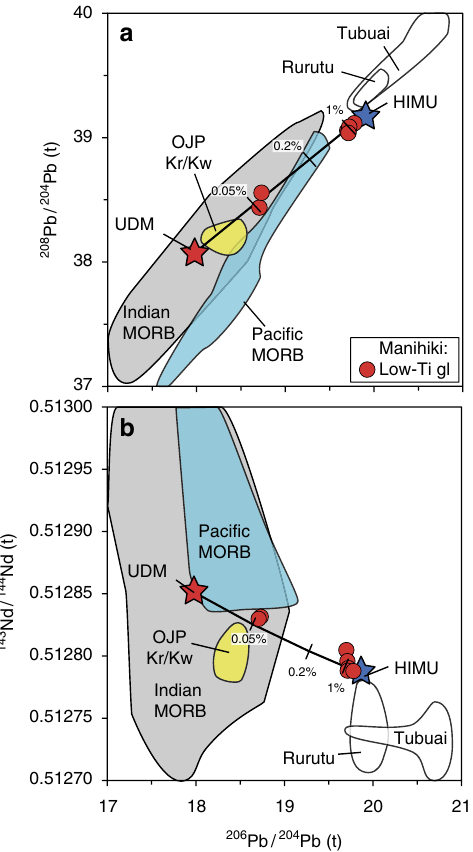
Figure 3 | Radiogenic isotopic composition of low-Ti Manihiki rocks. Initial radiogenic isotope ratio plots (with correction for radiogenic ingrowth to 120Myr ago) of ( a ) 206 Pb/ 204 Pb versus 208 Pb/ 204 Pb and ( b ) 206 Pb/ 204 Pb versus 143 Nd/ 144 Nd for low-Ti glasses. The stars represent the estimated UDM (red) and enriched (blue) end members for the Manihiki low-Ti tholeiites. The enriched melt end member for the Manihiki low-Ti tholeiites has characteristics similar to HIMU-like OIB lavas from Rurutu and Tubuai 69 of the Cook-Austral Chain (see discussion, Supplementary Fig. 2 for calculation of the Manihiki-enriched end member). The black lines show mixing of UDM with variable amounts (indicated at tick marks in wt%) of the enriched OIB-like component represented by a mafic Rurutu lava sample from ref. 34. Note: 143 Nd/ 144 Nd ratio for intermediate sample SO225DR12-2 was not included for end member calculations (see ‘Sample material’ in the ‘Methods’ section). Isotope data for the Kroenke/Kwaimbaita field were taken from refs 10,11. The MORB-field data 70 were projected to 120Myr using the following parent/ daughter ratios from ref. 4: 147 Sm/ 144 Nd ¼ 0.25, 87 Rb/ 86 Sr ¼ 0.005, 238 U/ 204 Pb ¼ 10, 235 U/ 204 Pb ¼ 0.073, 232 Th/ 204 Pb ¼ 40. The Indian MORB 70 field was projected to 120Myr using calculated parent/daughter ratios based on the incompatible element composition of E-DMM from ref. 33. The fields for the Tubuai and young Rurutu lavas were also projected to 120Myr ago and plotted based on compiled literature data and parent/daughter ratios from the calculated OIB source from ref. 36 and references and spinel, which are the only liquidus phases, and thus the application of the model, involving incremental addition of olivine to the evolved melt, is straightforward. The calculated primary magmas are in equilibrium with olivine Fo 91.1–91.3 , have high MgO (15.7–17.0 wt%) and CaO (10.4–11.0 wt%), and are peridotite-derived compositions (Supplementary Table 3).